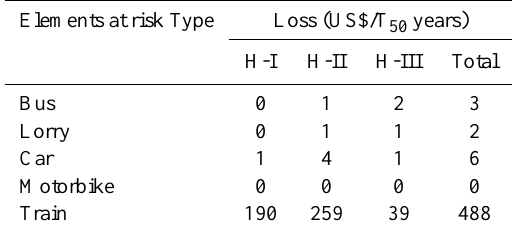
Table 8. Direct specific risk of the person most at risk using vehicle and